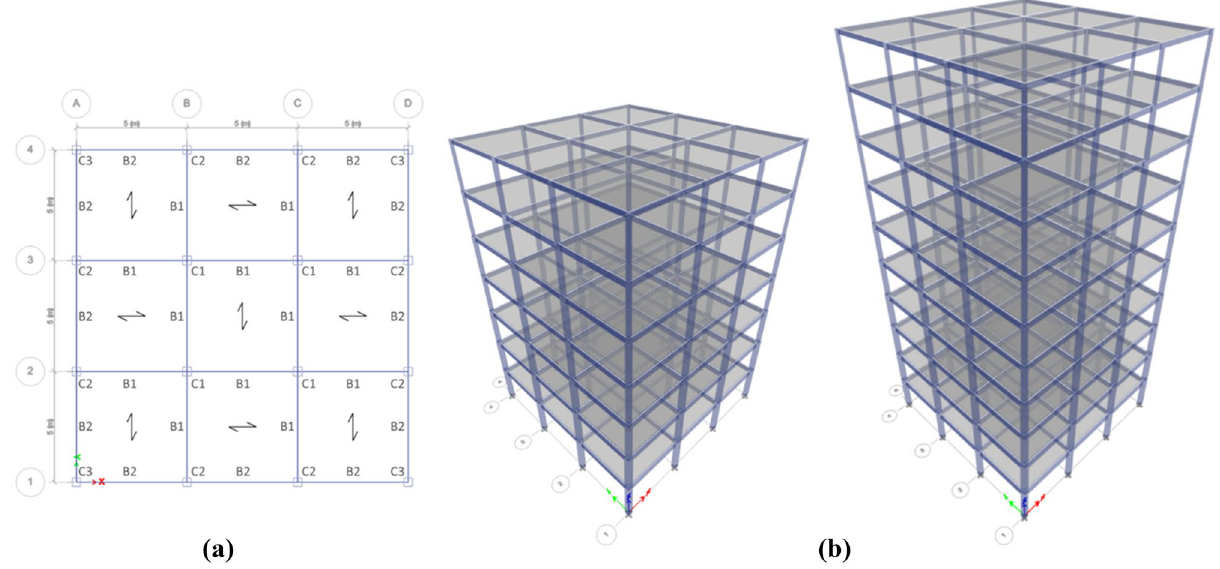
Figure 4. The ( a ) structural plan and ( b ) views of the regular 7 and 10-story structures.